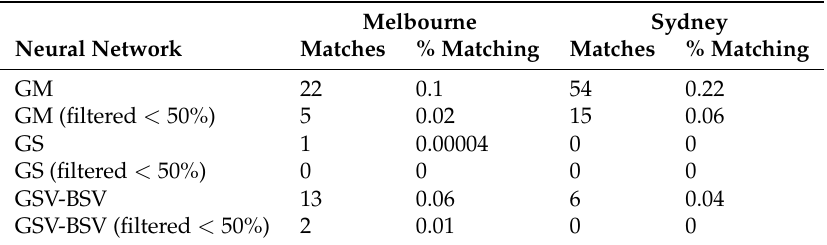
Table 3. How much are Melbourne and Sydney like Paris? The table shows neural network results, both unfiltered and filtered (where predictions with probabilities less than 50% are removed). Melbourne Sydney Neural Network Matches % Matching Matches %